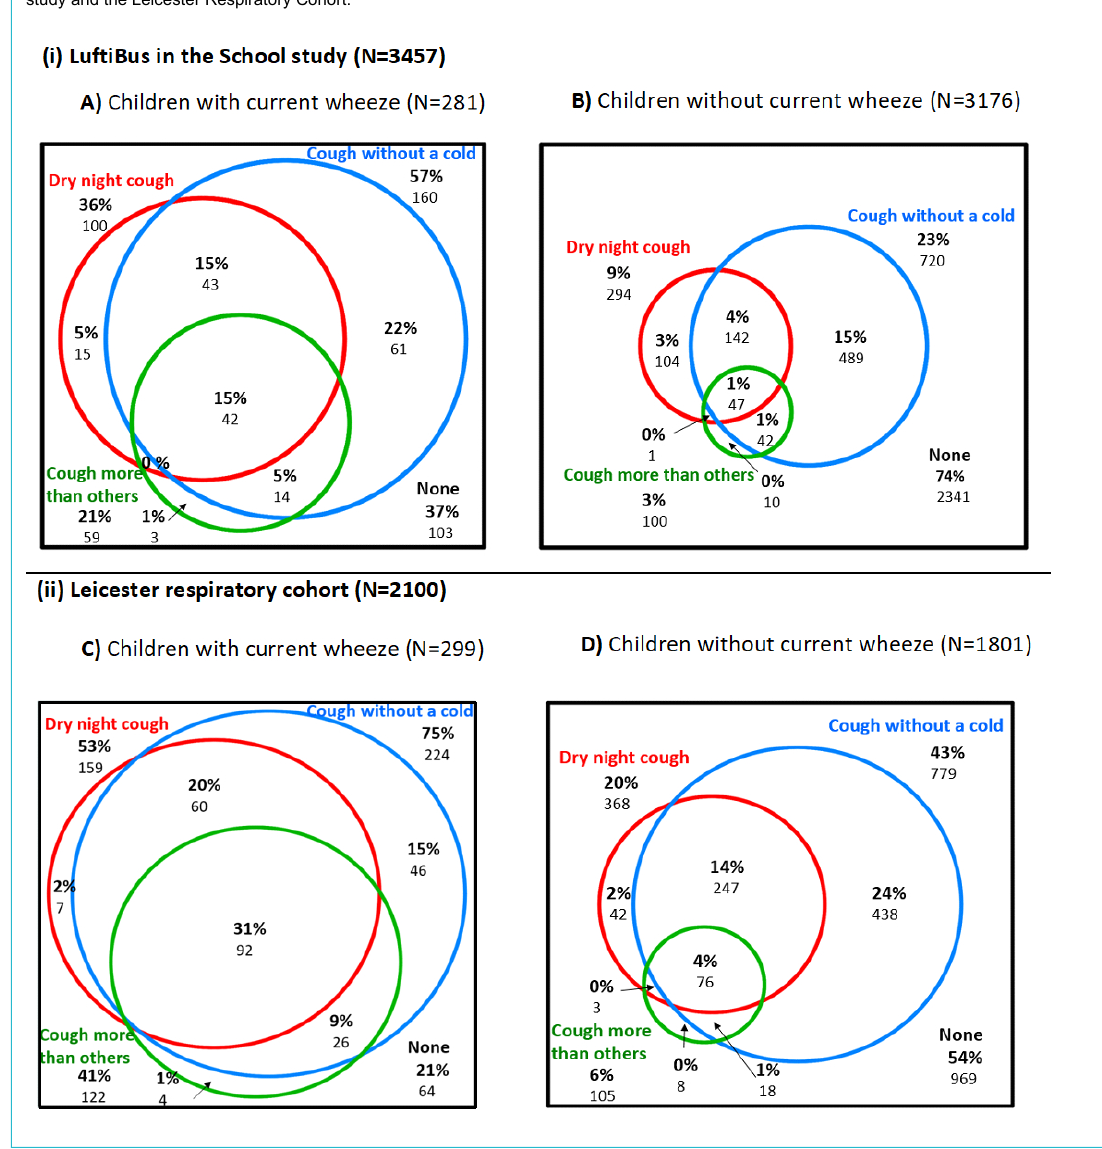
Figure 2: Venn diagram showing the overlap between parents’ answers to three different questions on cough in the LuftiBus in the school study and the Leicester Respiratory